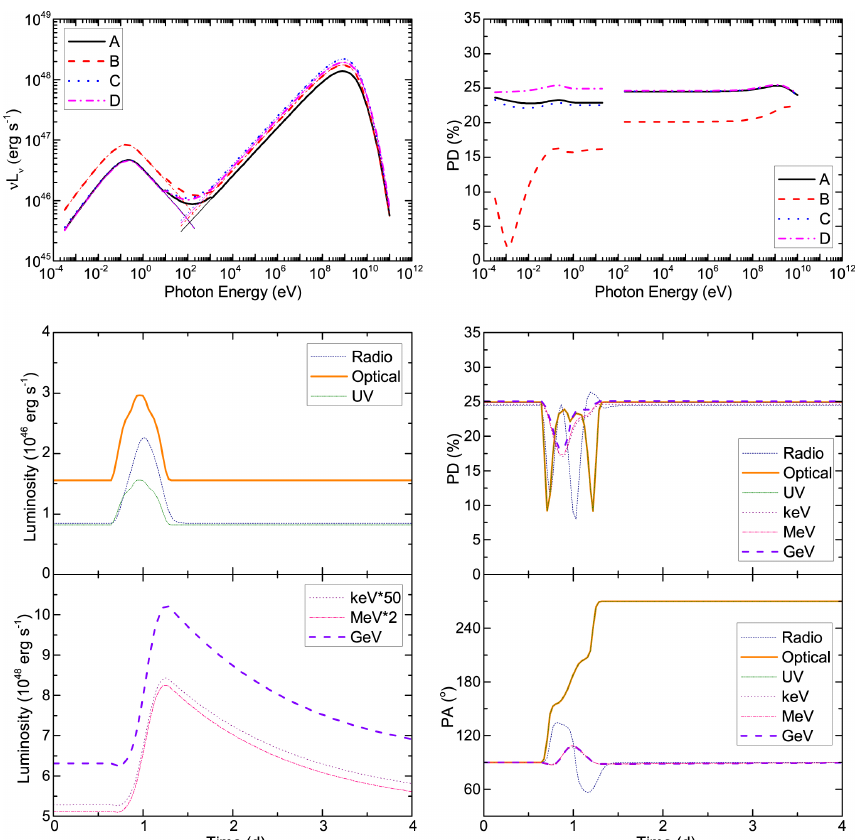
Figure 22. Representative simulations of a hadronic shock emission model with polarization predictions. Top lef t: Snap-shot SEDs, Middle and bottom left : Multi-wavelength light curves, Top right : Frequency-dependent polarization degree at different times, Middle right : Time-dependence of polarization degree at various frequencies, Bottom right : Time-dependent PA at various